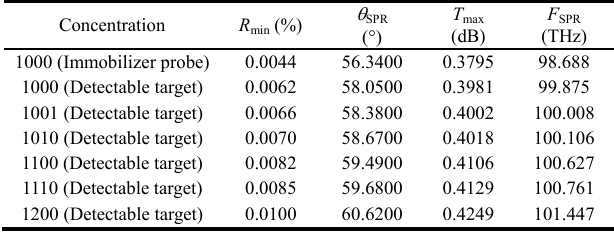
ranging from 1000 nM to 1200 nM.